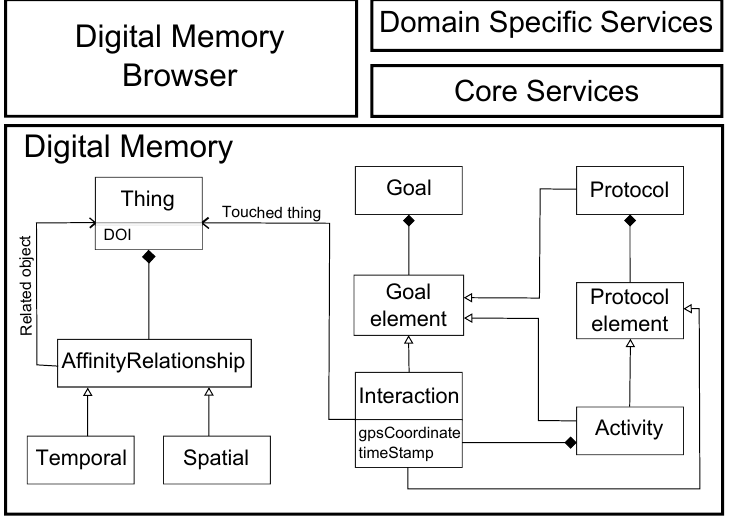
Dig-Mem Overview. Main elements that can be mounted on our bases of Dig-Mem (top). The core element of our approach, Digital Memory concepts (bottom). Domain Specific Services Digital Memory Browser Core Services Digital Protocol